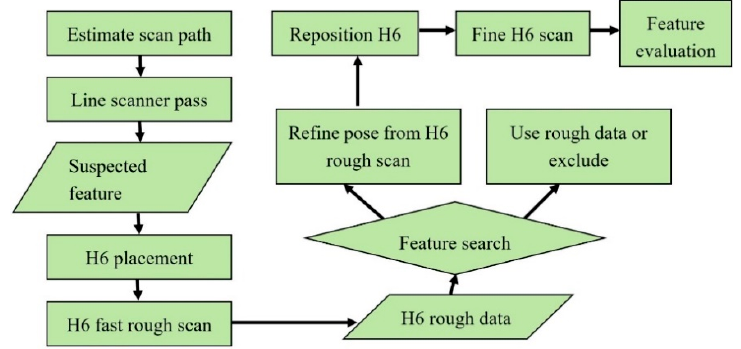
Figure 16. Proposed robotic inspection strategy.